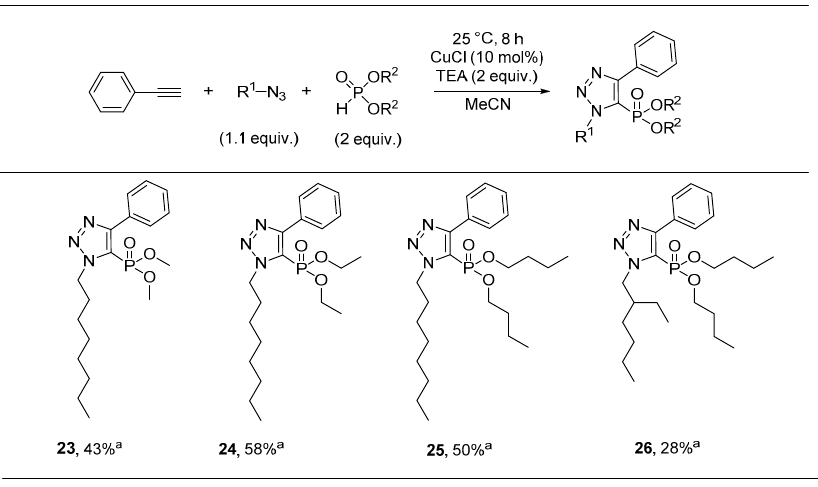
Scheme 4. Domino reaction of phenylacetylene, aliphatic azides and dialkyl phosphites. a Isolated